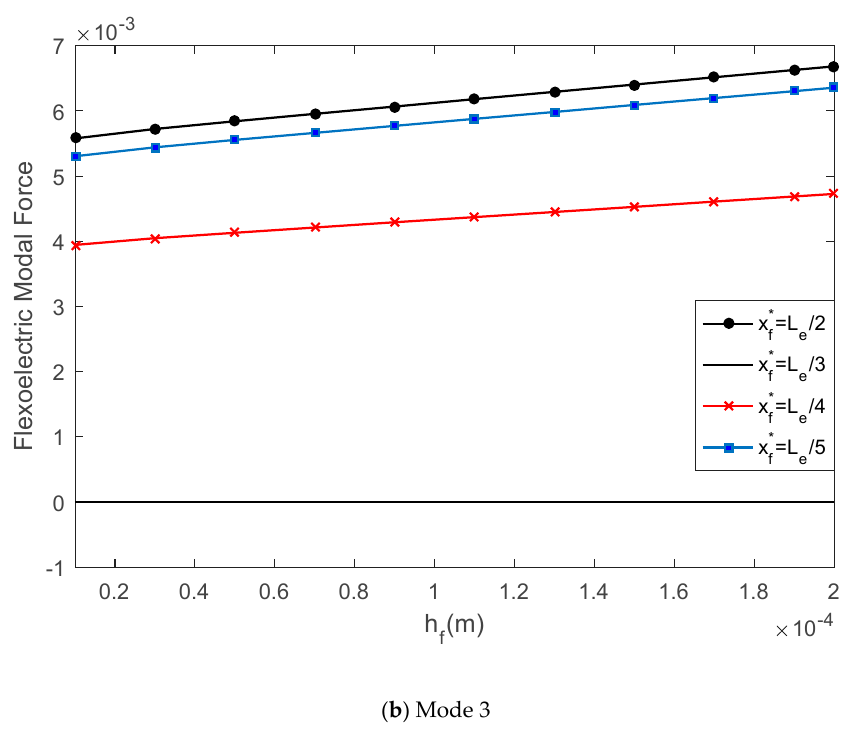
Figure 8. The e ff ect of the flexoelectric patch thickness on the flexoelectric modal force, ( a ) mode 1, ( b ) mode 3.